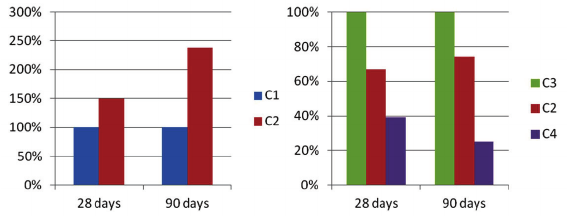
Fig. 14. Effect of the use of natural pozzolans and change in amount of ITZ in sorptivity coefficient